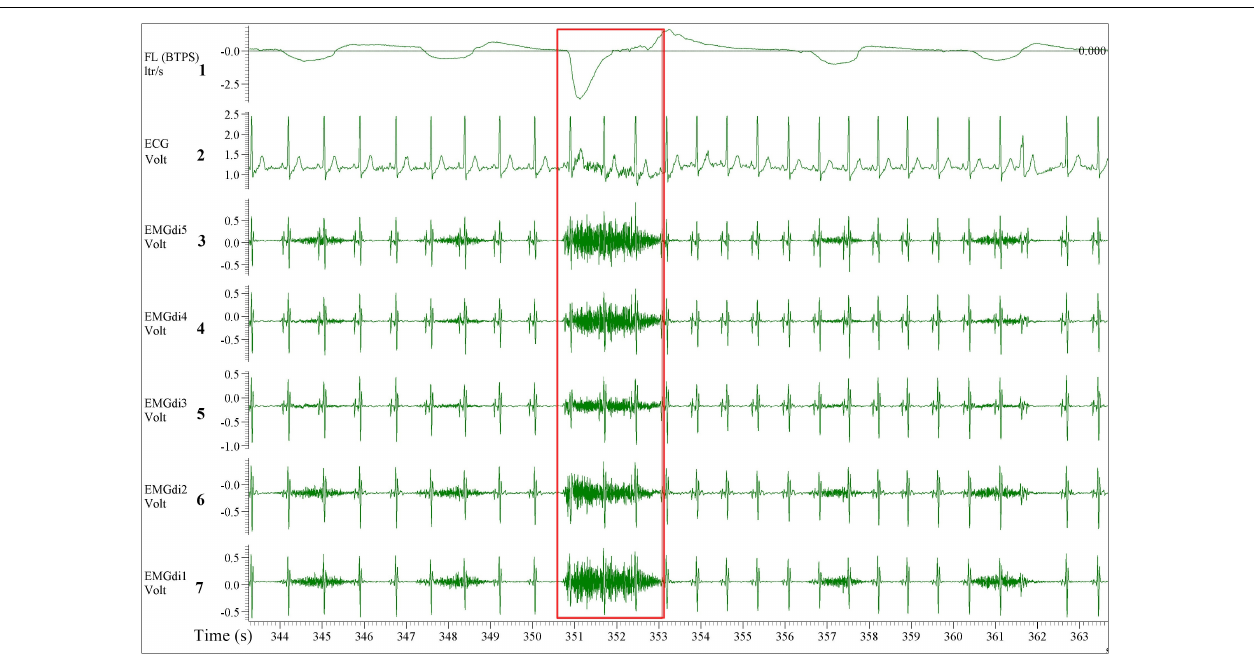
FIGURE 1 | A five diaphragm EMG (EMGdi) channel recording contains electrocardiogram (ECG) artifacts during resting breathing. From top to bottom the channels are as follow; Channel 1: respiratory flow (l/s; negative flow indicating the inspiratory cycle), Channel 2: ECG recording (volt), Channels 3–7: EMGdi recordings. The correct positioning of the catheter is shown when the largest EMGdi amplitudes are in the outer EMGdi channels (3 and 7), and the smallest amplitude is in the middle channel (5). The inspiratory capacity (IC) maneuver is highlighted in the red box indicated by the higher flow, which accompanies the maximal activation of the diaphragm